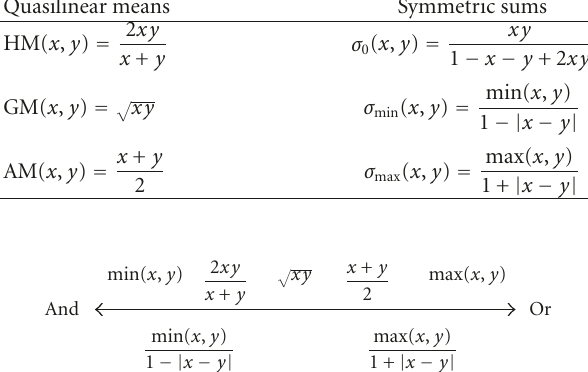
Figure 7: Ordering of aggregation operators adopted from [30].